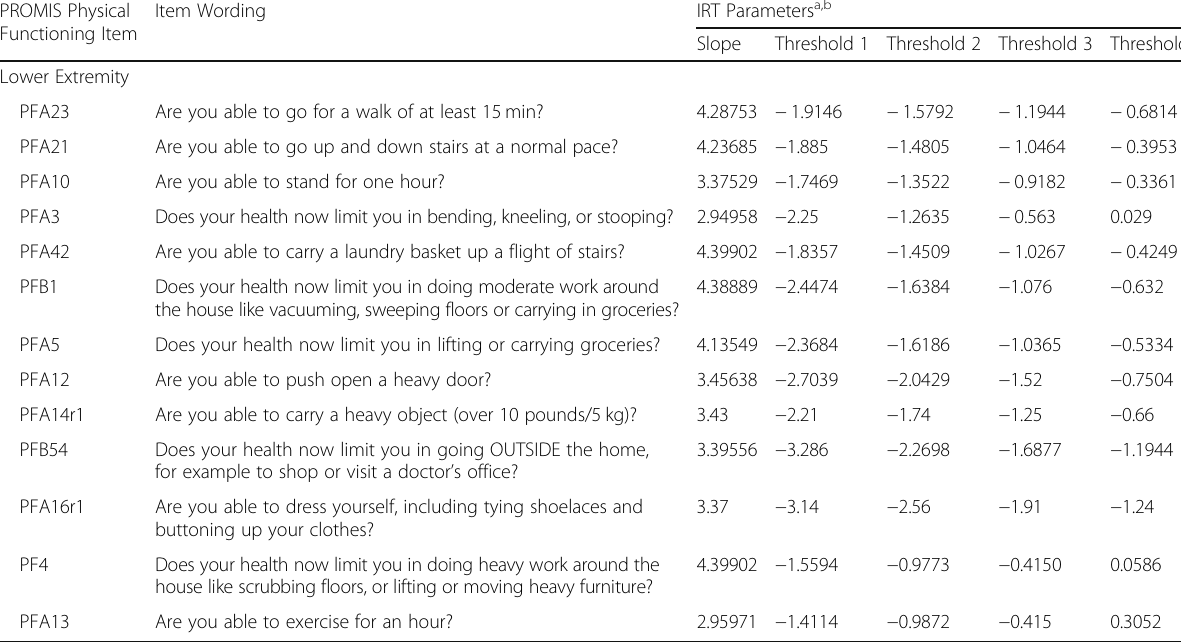
Table 2 PROMIS-PF items and parameters PROMIS Physical Item Functioning Item